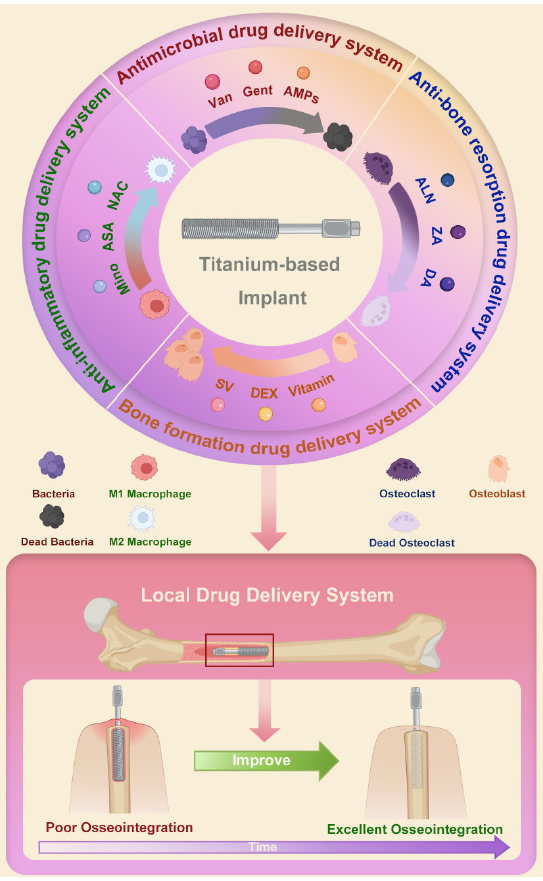
Figure 1. Schematic of local drug delivery systems using Ti-based implant and their role in improving osseointegration. Abbreviations: Van: vancomycin; Gent: gentamicin; AMPs: antimicrobial peptides; ALN: alendronate; ZA: zoledronic acid; DA: dopamine; SV: simvastatin; DEX: dexamethasone; Mino: minocycline; ASA: aspirin; NAC: N-acetyl cysteine.